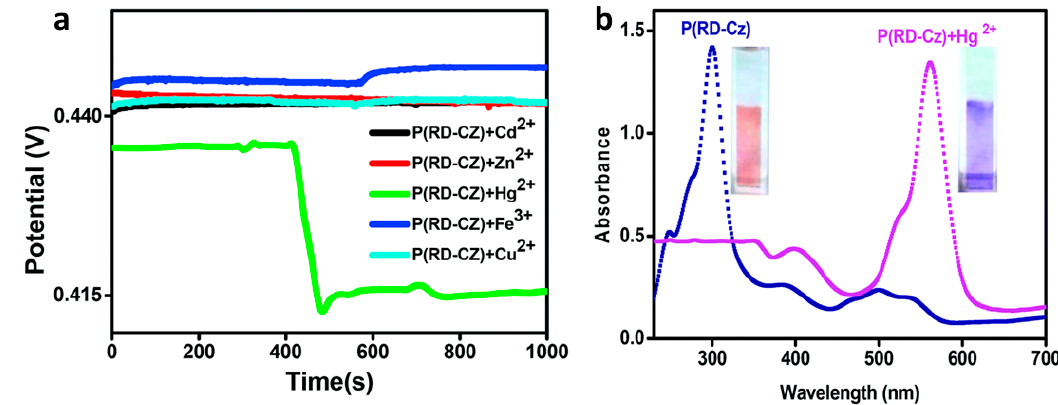
Figure 7. ( a ) A carbazole-based CP electrode’s potentiometric response to Hg 2+ ions is easily differentiated from its response to other metal ions. ( b ) The same CP can also be used as a colorimetric